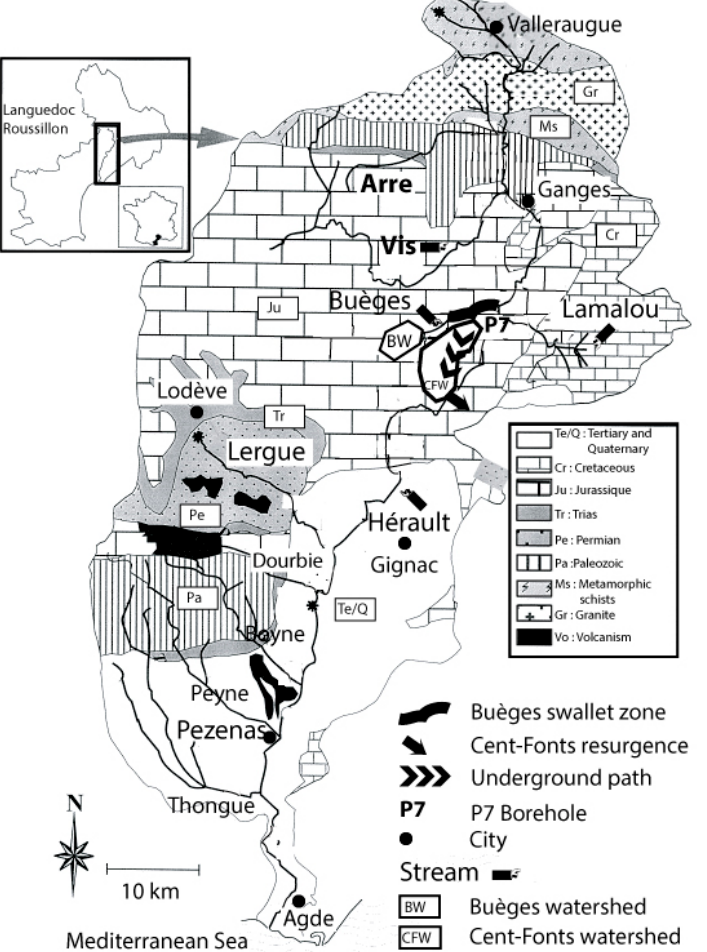
Figure 1. Simplified geological map of the Cent-Fonts karst, redrawn after Petelet et al. [16]. Note the location of the P7 borehole where far field temperature ( T ∞ ) has been recorded.